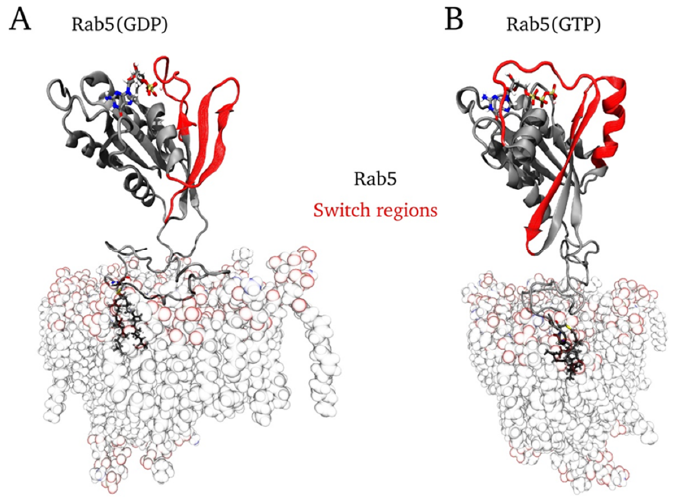
Figure 8. Initial conformations of full-length membrane-bound ( A ) Rab5(GDP) and ( B ) Rab5(GTP) (here in the six-component membrane), which was identical for either one- or two-fold geranylgeranylated HVR.